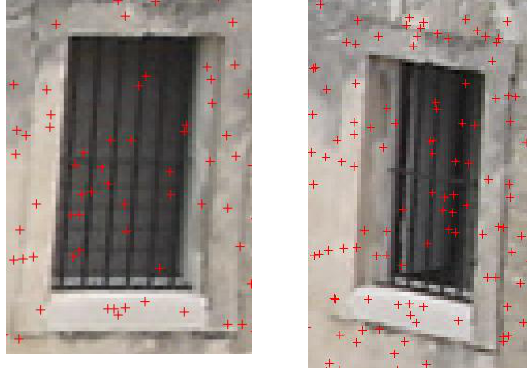
Figure 2. SURF matching results for an image pair